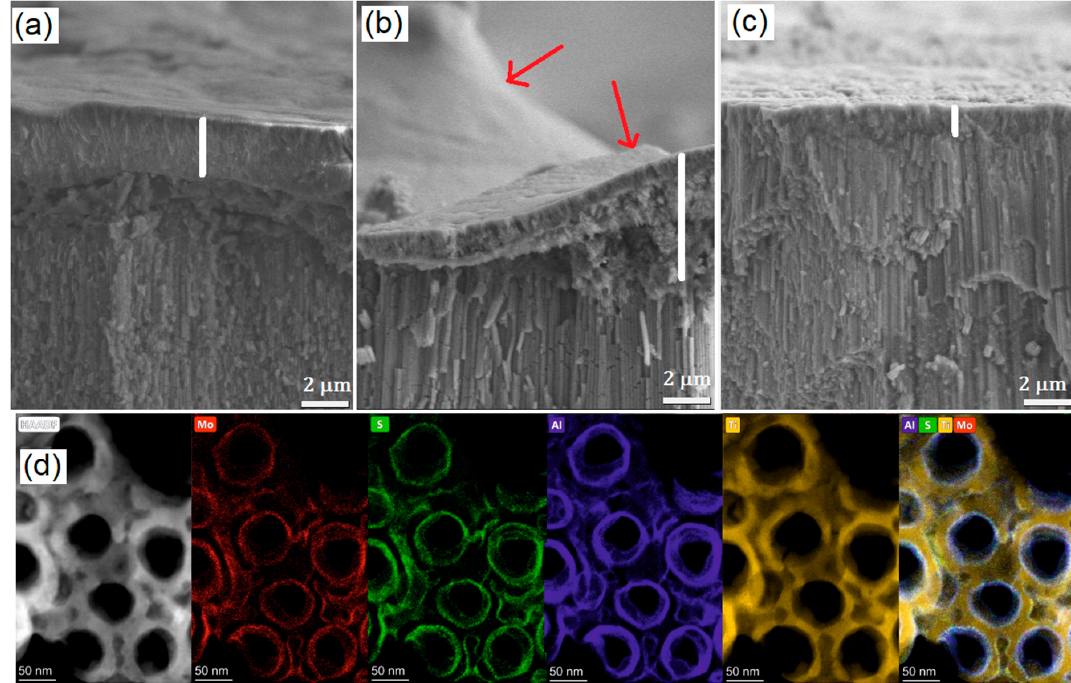
Figure 6. Cross sectional SEM images of ( a ) as-prepared TNTs, ( b ) MoS 2 -TNTs, and ( c ) Al 2 O 3 /MoS 2 /Al 2 O 3 -TNTs after 200 cycles at 3C. Solid electrolyte interphase (SEI) layer thickness and surface roughness is indicated by a white line and red arrows. ( d ) High magnification STEM HAADF image and the STEM-EDX elemental maps showing the distribution of Mo, S, and Al on the surface of the TNT for Al 2 O 3 /MoS 2 /Al 2 O 3 -TNTs.